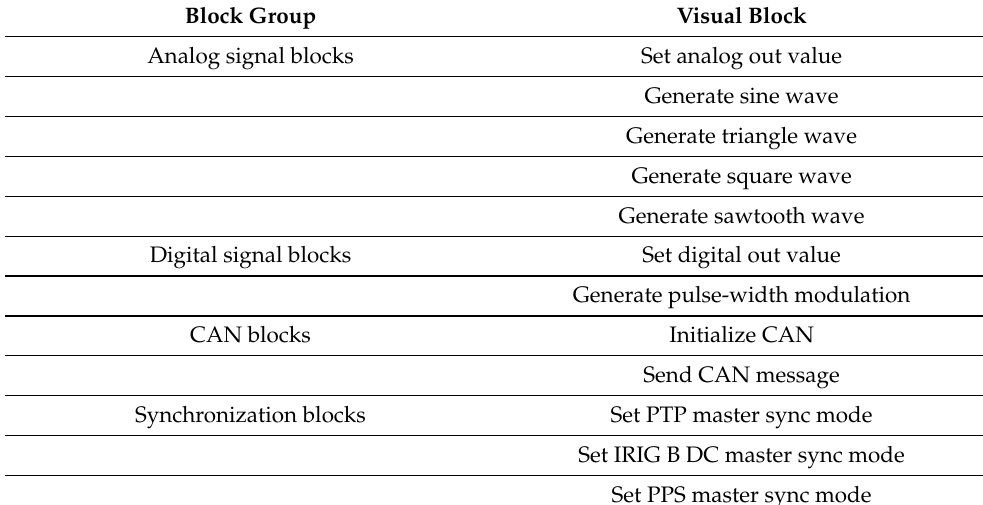
Table 1. New set of DSML visual blocks.